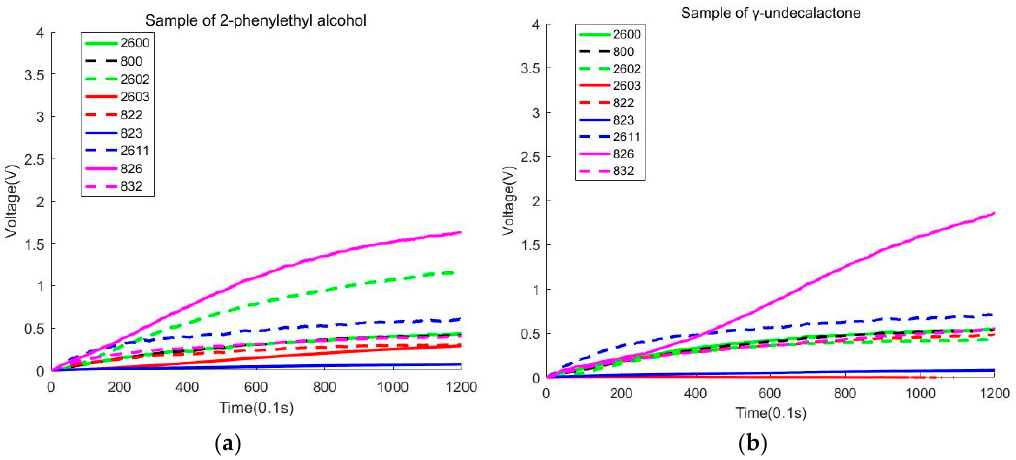
Figure 3. (a) Sample of 2-phenylethyl alcohol.(b) Sample of γ -undecalactone. Figure 3. ( a ) Sample of 2-phenylethyl alcohol. ( b ) Sample of γ